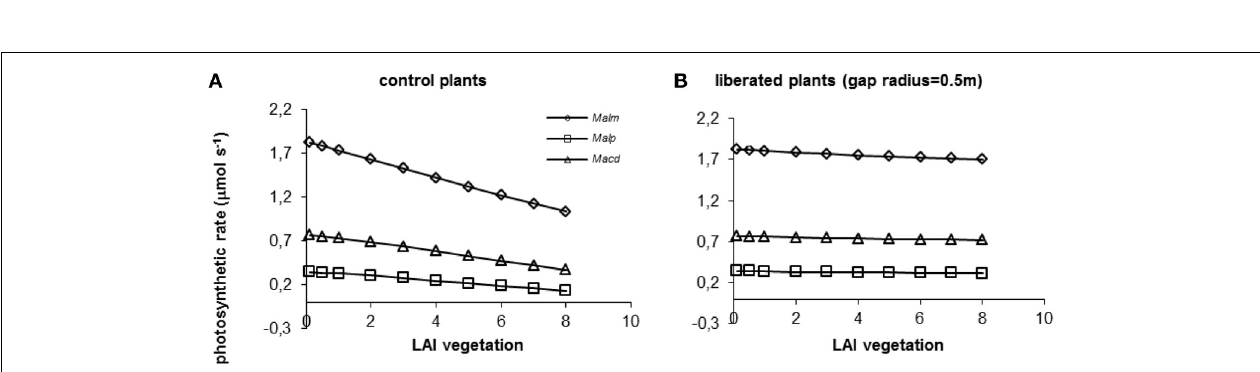
FIGURE 6 | (A–F) Model simulations of the effect of gap radius (log scale) on whole canopy light capture and photosynthetic rate of species in a 1.5 y/o secondary forest stand. Mean parameter values were used for each species and treatment. For abbreviations see Figure 3 .